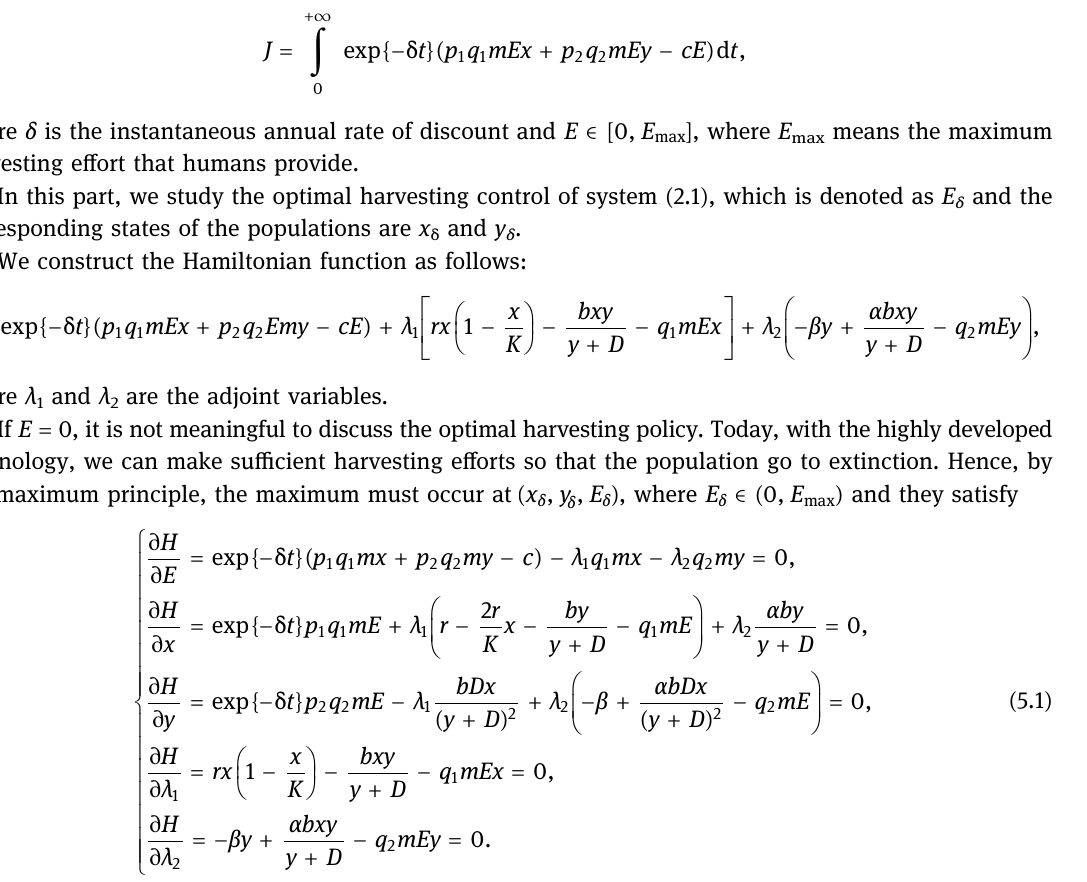
Table 2: The price of prey fi sh p 1 changes from 5 to 11 with = = c p 60, 12 p